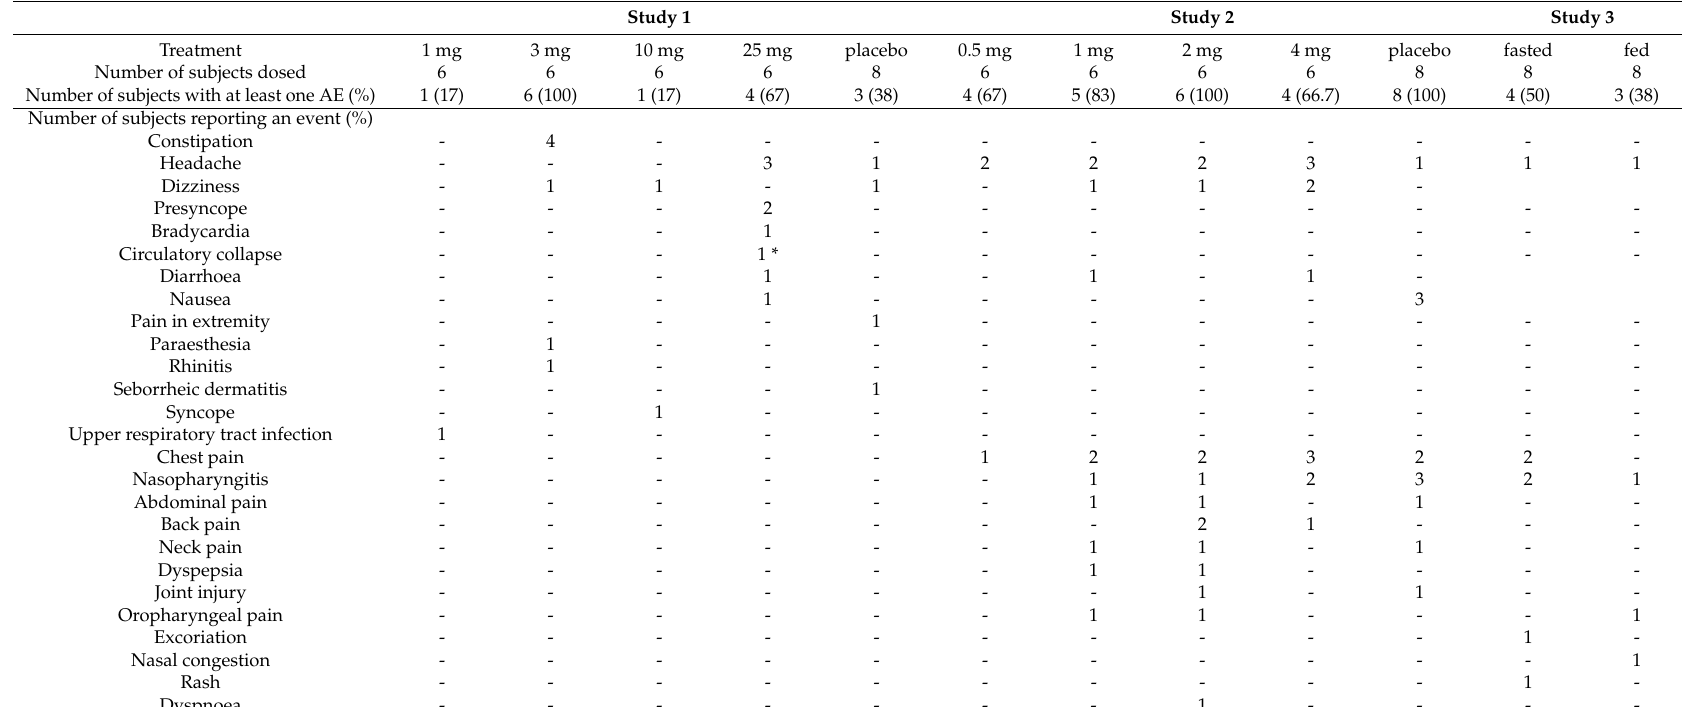
Table 3. Treatment-emergent adverse events (AEs) in Study 1, Study 2 and Study